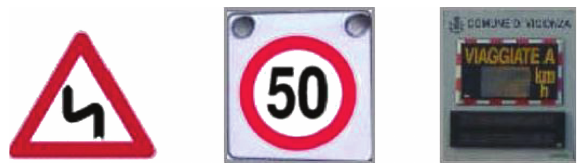
Figure 3: Types of vertical signs inserted in driving environment B.